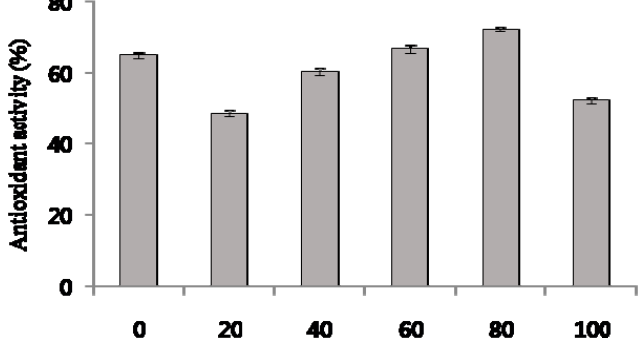
Figure 3. 2,2-Diphenyl-1-picrylhydrazyl (DPPH) scavenging effect in ethanolic extracts from C. tricuspidata leaves. 0–100 on x -axis: 0–100% ethanolic extract. Each value was the mean ± SD ( n = 3). Table 5. Antioxidant activity and total phenolic content of C. tricuspidata leaf extracts. Extract